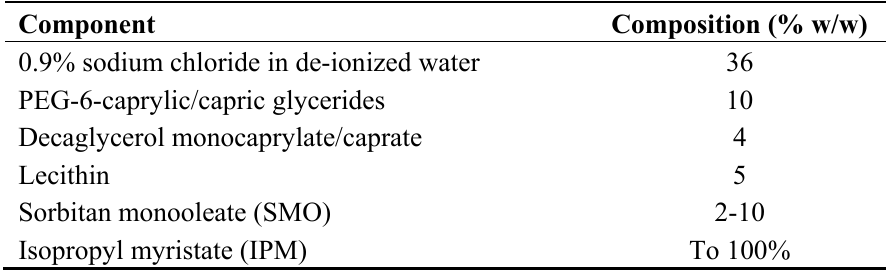
Table 1. Composition of lecithin-linker microemulsion phase